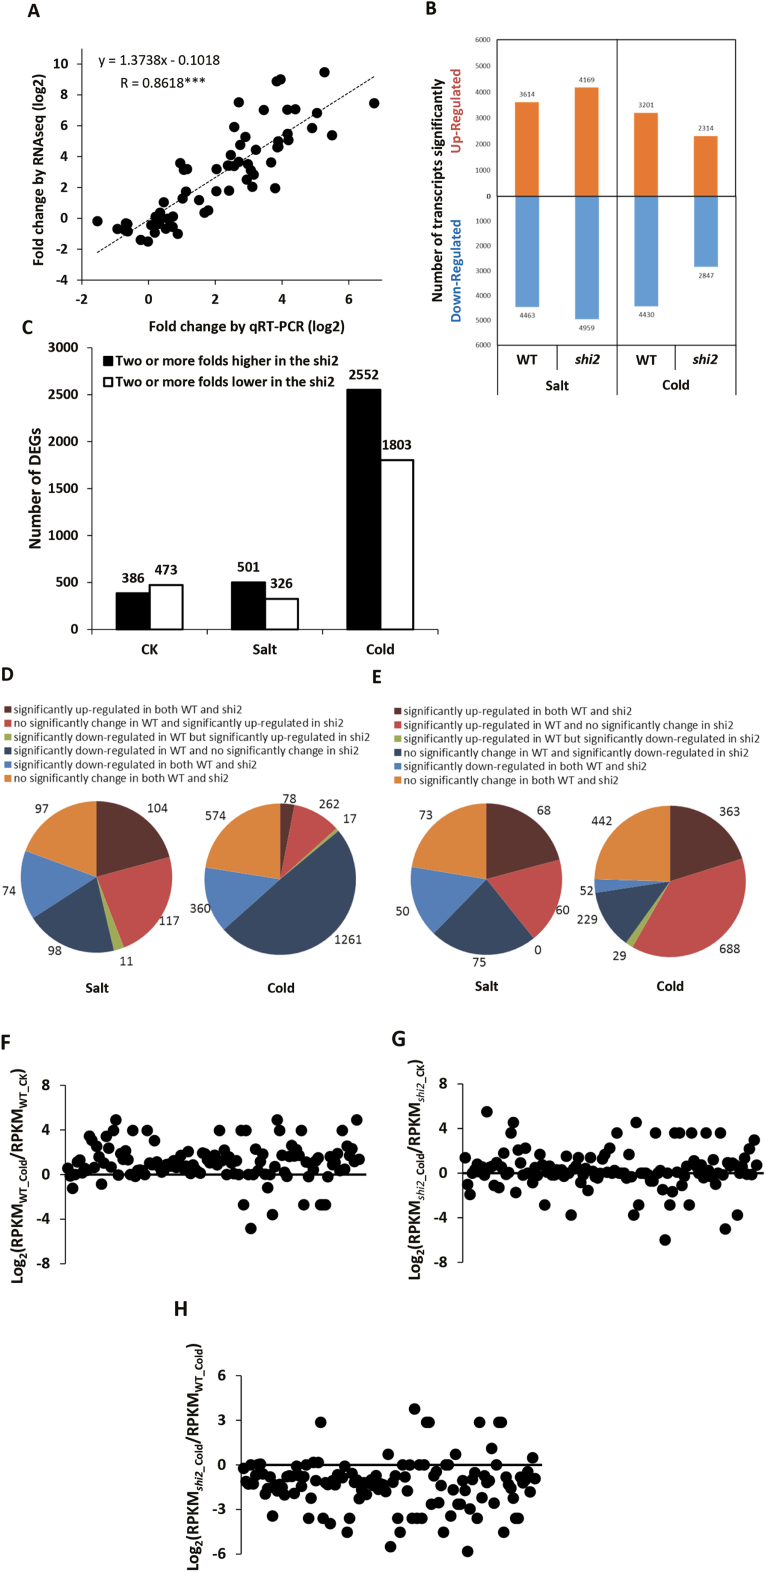
Transcriptome analysis of the wild type and shi2 mutant. (A) Correlations between RNA-seq data and RT–qPCR data of the16 selected genes (***P<0.001). (B) The numbers of significantly up- and down-regulated genes (≥2-fold change, P<0.05, FDR <0.05) in the wild type and shi2 mutant after salt and cold treatments. (C) The number of ≥2-fold changed (P<0.05, FDR <0.05) DEGs between the wild type and shi2 mutant under normal, salt, and cold stress conditions. (D) and (E) Analysis of DEGs at least 2-fold higher (D) or 2-fold lower (E) in the shi2 mutant after salt or cold stress. All DEGs were divided into six groups based on their changes in expression levels in the wild type and shi2 mutant. (F) and (G) Comparison of the expression levels of mitochondria-encoded genes in the wild type (F) or the shi2 mutant (G) before and after cold stress. (H) Comparison of the expression levels of the mitochondria-encoded genes between the wild type and shi2 mutant after cold stress. For (F) and (G), each dark dot represents a mitochondria-encoded gene. The horizontal line indicates an equal expression level before and after cold stress. The dot above the line means up-regulation of this gene after cold stress, and the dot below the line means down-regulation of this gene after cold stress. For (H), each dark dot represents a mitochondria-encoded gene. The horizontal line indicates an equal expression level between the wild type and the shi2 mutant. The dot above the line means the expression level of this gene is higher in the shi2 mutant than in the wild type, and the dot below the line means the expression level of this gene is lower in the shi2 mutant than in the wild type. (This figure is available in color at JXB online.)